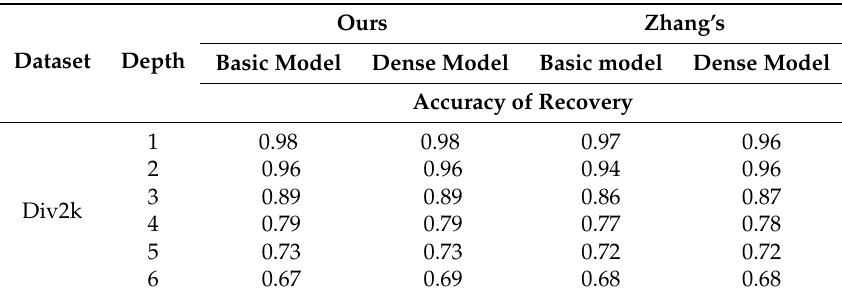
Table 4. The accuracy of the Decoder network compared with Zhang’s